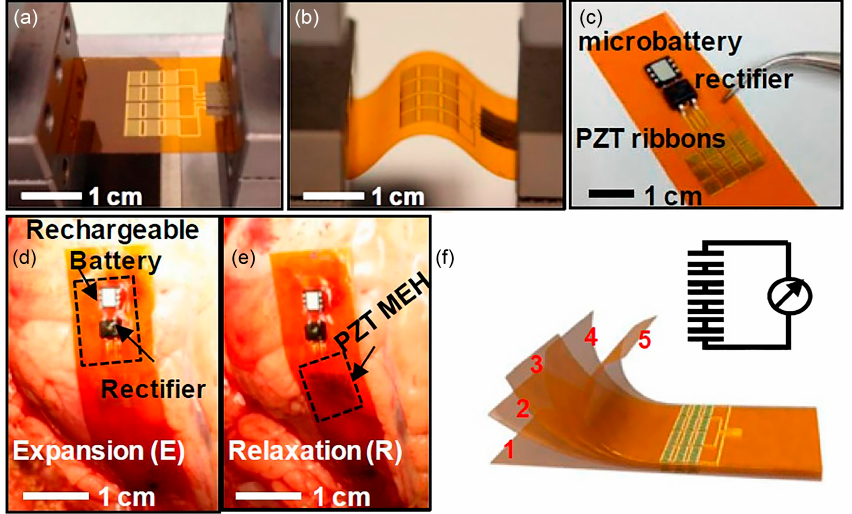
Figure 10. ( a ) Gold IDEs patterned on the flexible PZT film and the simulated potential distribution in PZT film between the adjacent electrodes. ( b ) The principle operation of piezoelectricity genera- estimated 45.6 V of piezoelectric potential using finite element analysis. PMN-PT layer con- tion in iPANS device (i) before and (ii) after bending deformation. ( c ) The attachment of an iPANS verted tiny biomechanical motion into electric energy with current signal of up to 145 µ A and output voltage of 8.2 V over a working area of 1.7 cm × 1.7 cm. The experimentally device on a 1 cm curvature radius of glass rod. ( d ) The conceptual schematic of flexible iPANS de- measured 8.2 V from the PMN-PT energy harvester was lower than the simulated result of vice insertion under BM in a mammalian cochlea. The upward bending at 600 nm due to sound 45.6 V presumably due to voltage drop from internal leakage paths and/or charge loss in wave vibration generates 3 V of piezoelectric potential [69]. the structure.